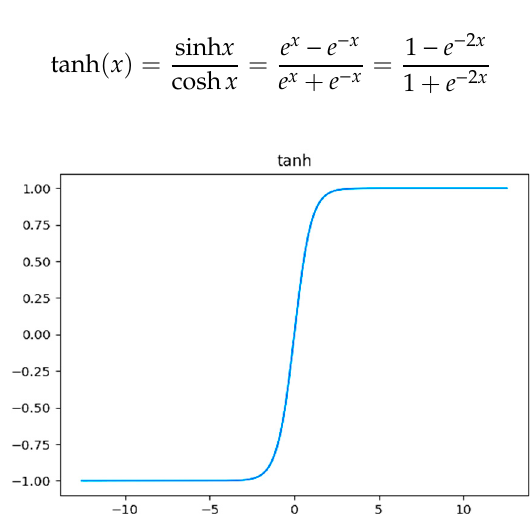
Figure 14. Conversion of the proposed double double-gated recurrent unit neural network (GRU-RNN). The activation function of RNN also has a soft saturation using the tanh function. As its output is centered at 0, the convergence speed is faster than the sigmoid function. The function image is shown in Figure 15.